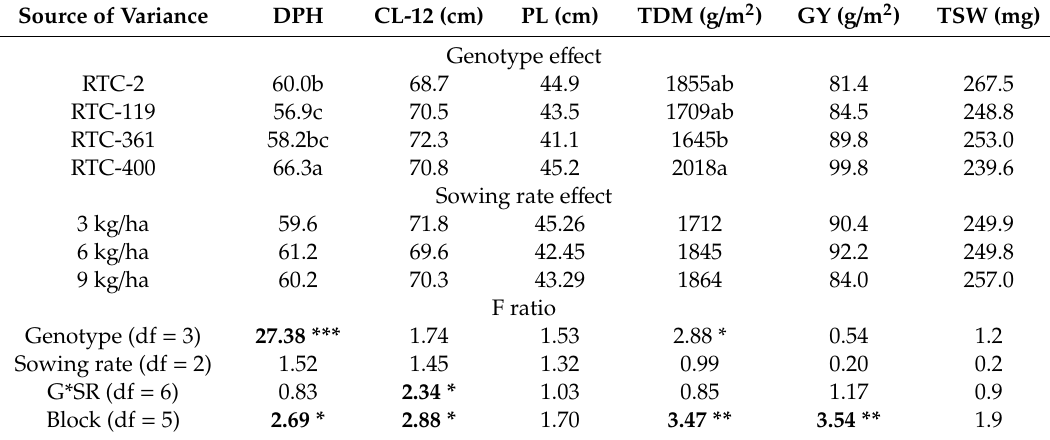
Table 3. Effects of genotypes and sowing rates on tef characteristics measured at the end of the 2019 season. Phenology: days from planting to heading (DPH); morphology: culm length at week 12 (CL-12), panicle length (PL); productivity: total dry matter (TDM), grain yield (GY), thousand seed weight